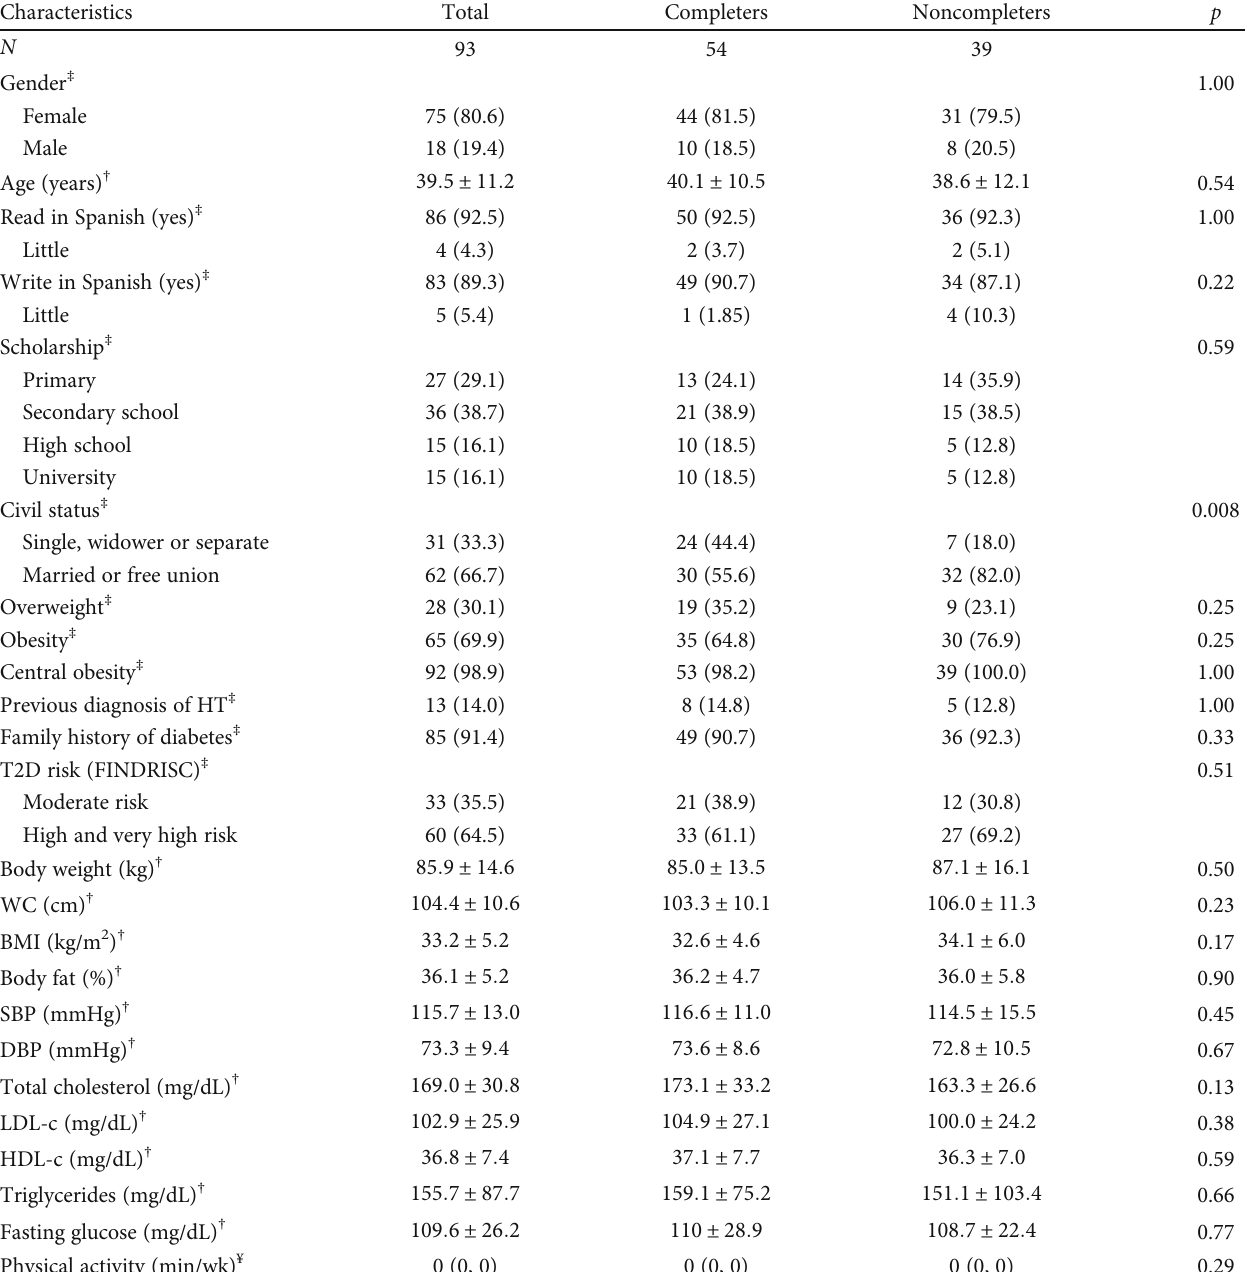
Table 2: Sociodemographic, clinical, and anthropometric characteristics of the participants.